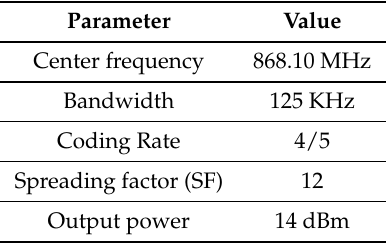
Table 1. LoRa module